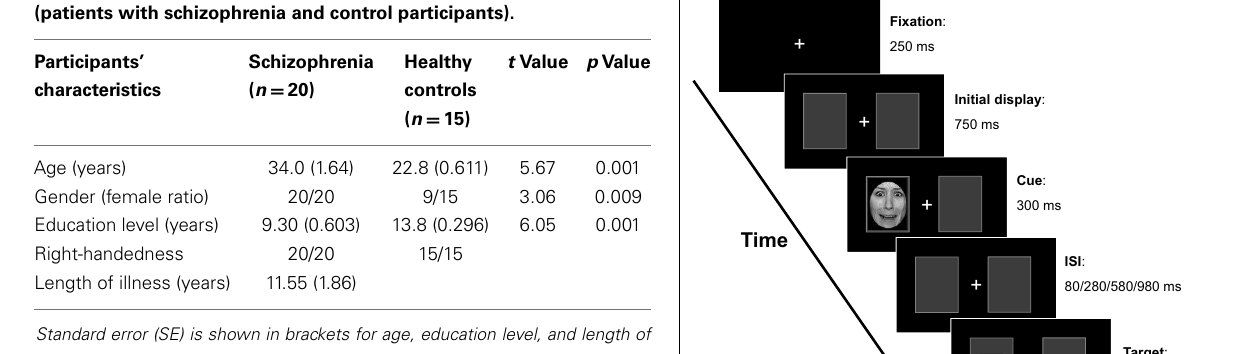
key as soon as possible once they detected the target (i.e., a square with a 0.90° × 0.90° visual angle). Stimuli were presented with